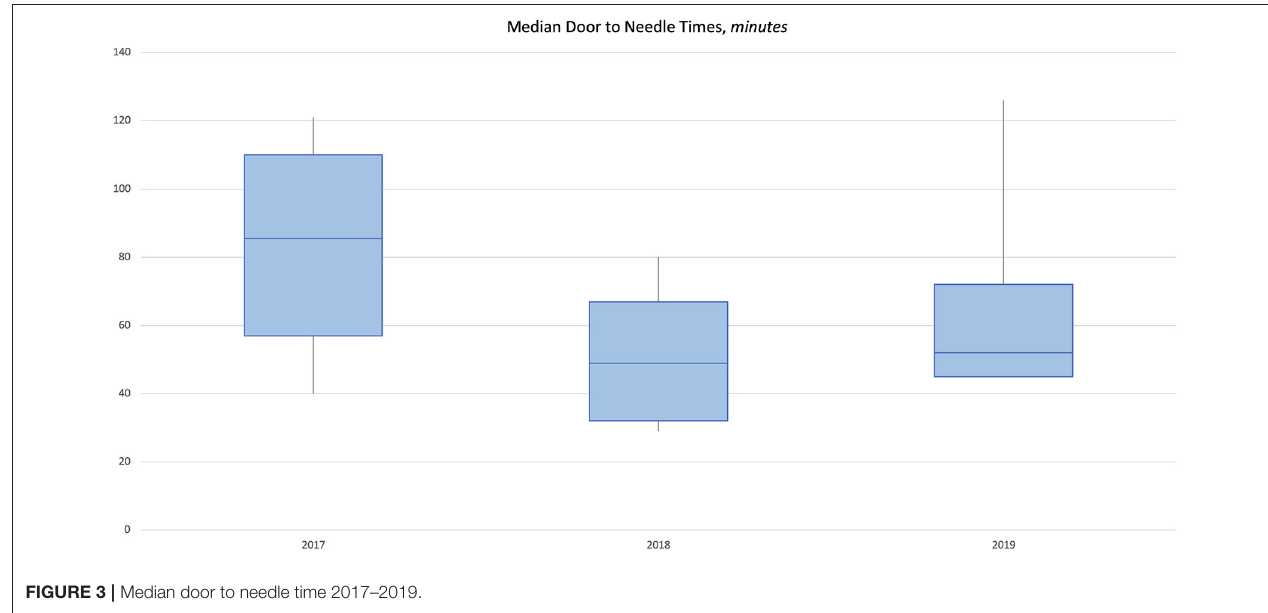
FIGURE 3 | Median door to needle time 2017–2019.